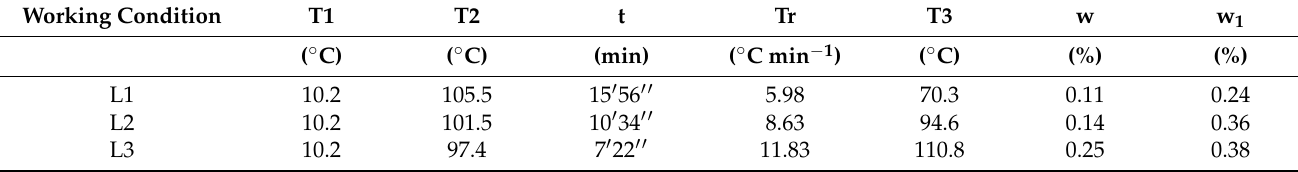
Table 3. Drying process parameters of soil at different rotation